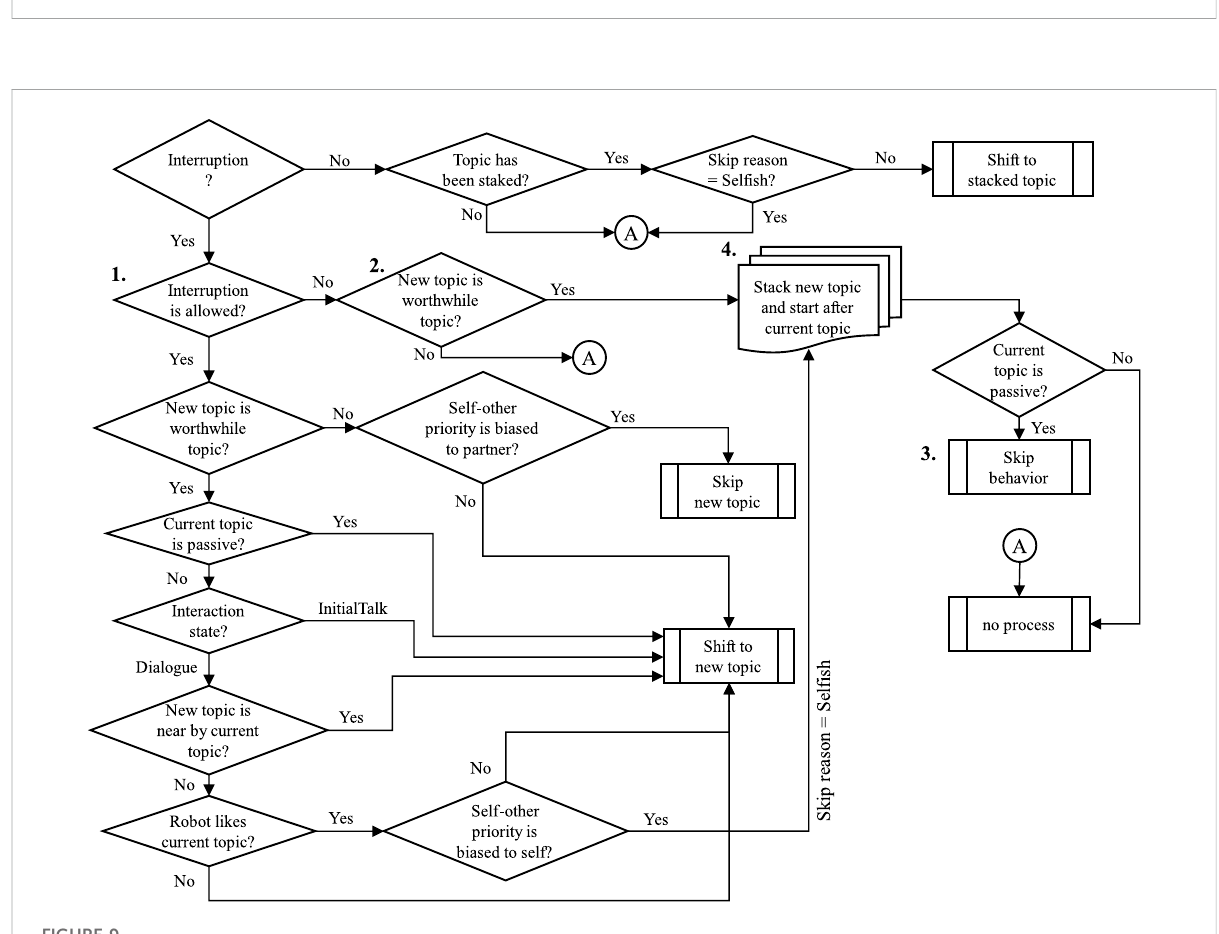
FIGURE 9 Flowchart of the interrupt